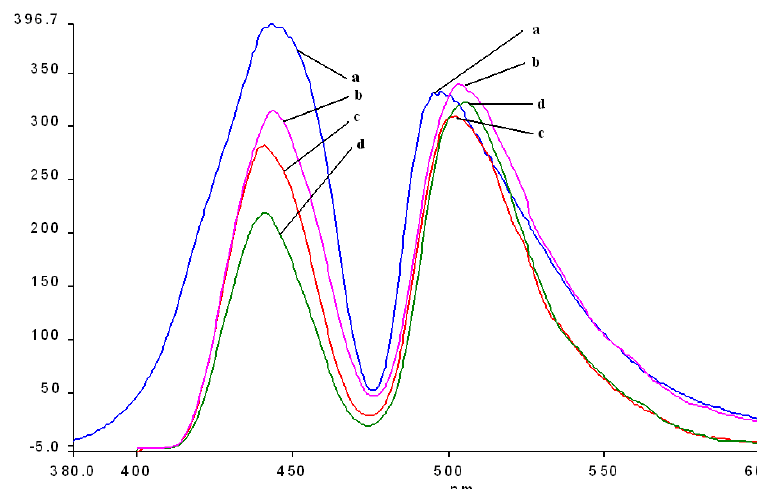
line d: 2a-AB ; in THF, at the same concentration.